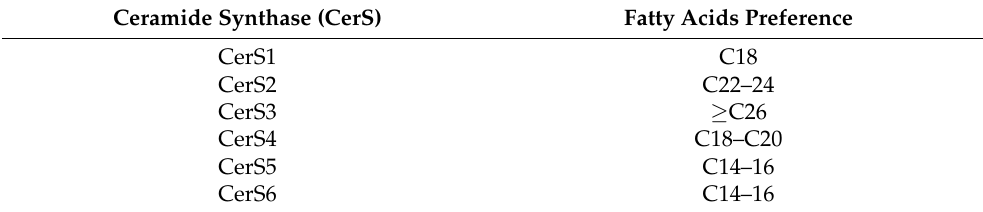
Table 1. Ceramide synthase isoforms and substrate